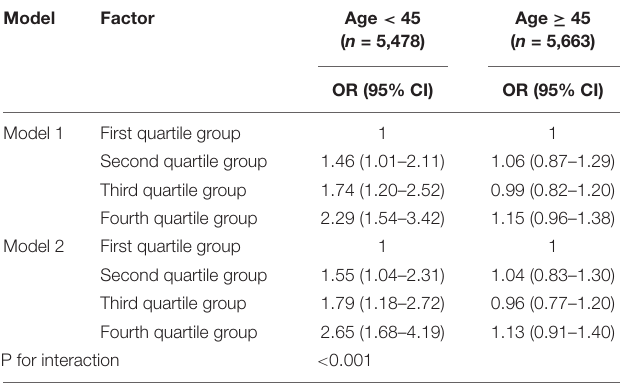
TABLE 4 | Bivariate and multivariate logistic regression analysis of HI in different age groups.